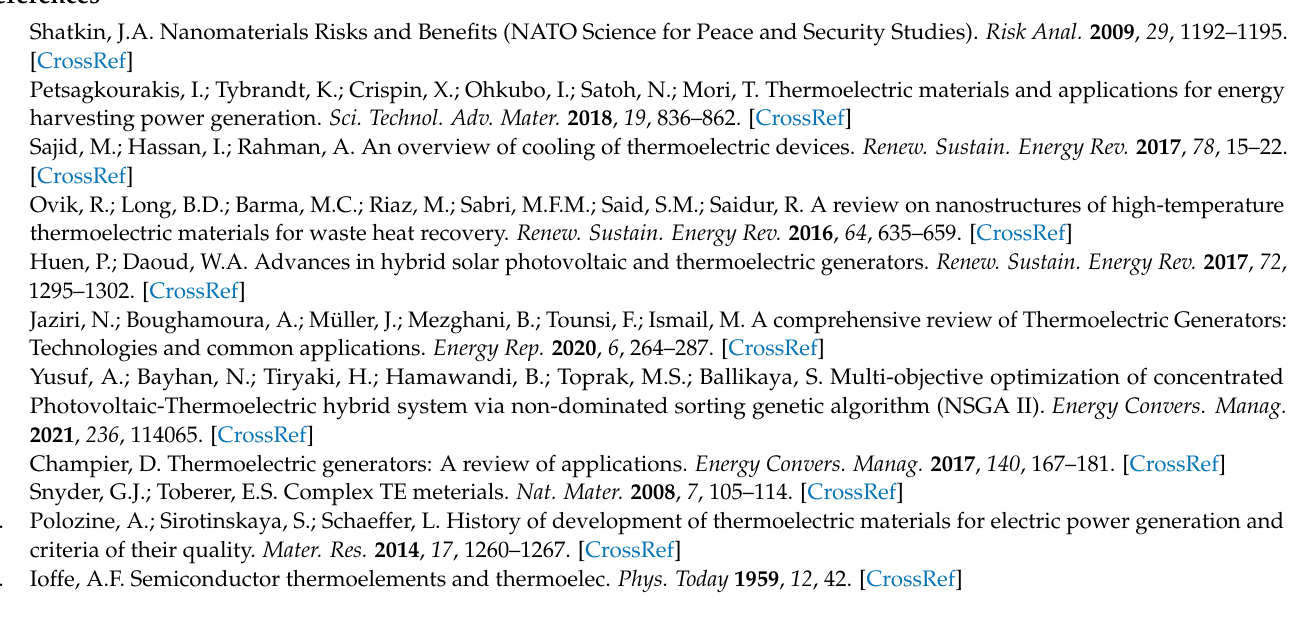
geometry for thermal diffusivity, using Laser Flash technique, and power factor measurements. Figure S2: Rietveld refinement for Hydro- Bi 2 Te 3 sample after SPS sintering, Figure S3: X-ray powder diffraction (XRPD) patterns showing a close up of the peaks with Miller indices of (006) and (015), Figure S4: Lorenz Number, Lo, estimated for Bi 2 Te 3 samples using parabolic band model, Table S1: Survey of the synthesis methods, reaction conditions, morphology and size of Bi 2 Te 3